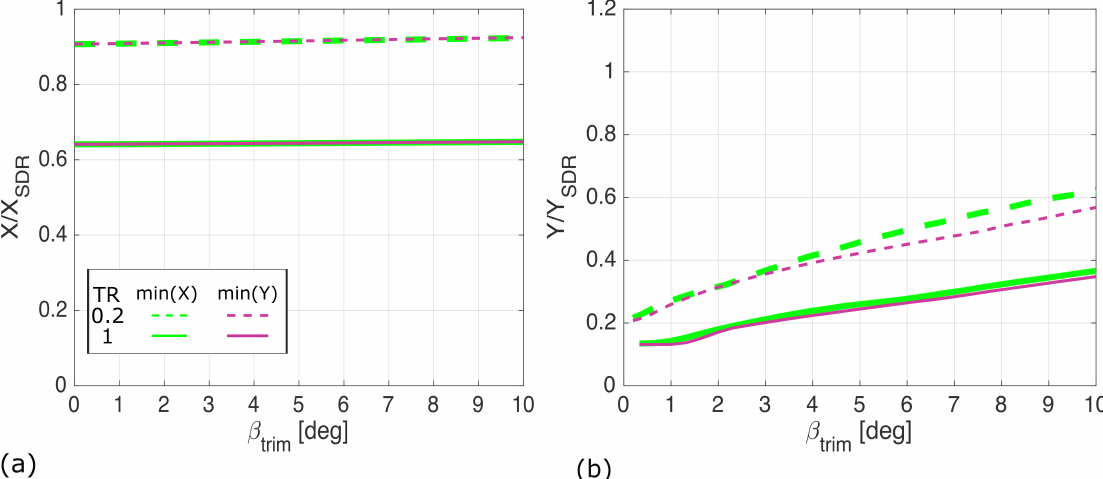
Figure 10. Relative contribution of the induced drag to the total drag ( a ) and the yawing moment ( b ) for the 30 degree swept wing. In all cases, the induced drag is responsible for over 99% of the yawing moment produced by this method and induced drag is responsible for approximately 42% of the total drag.